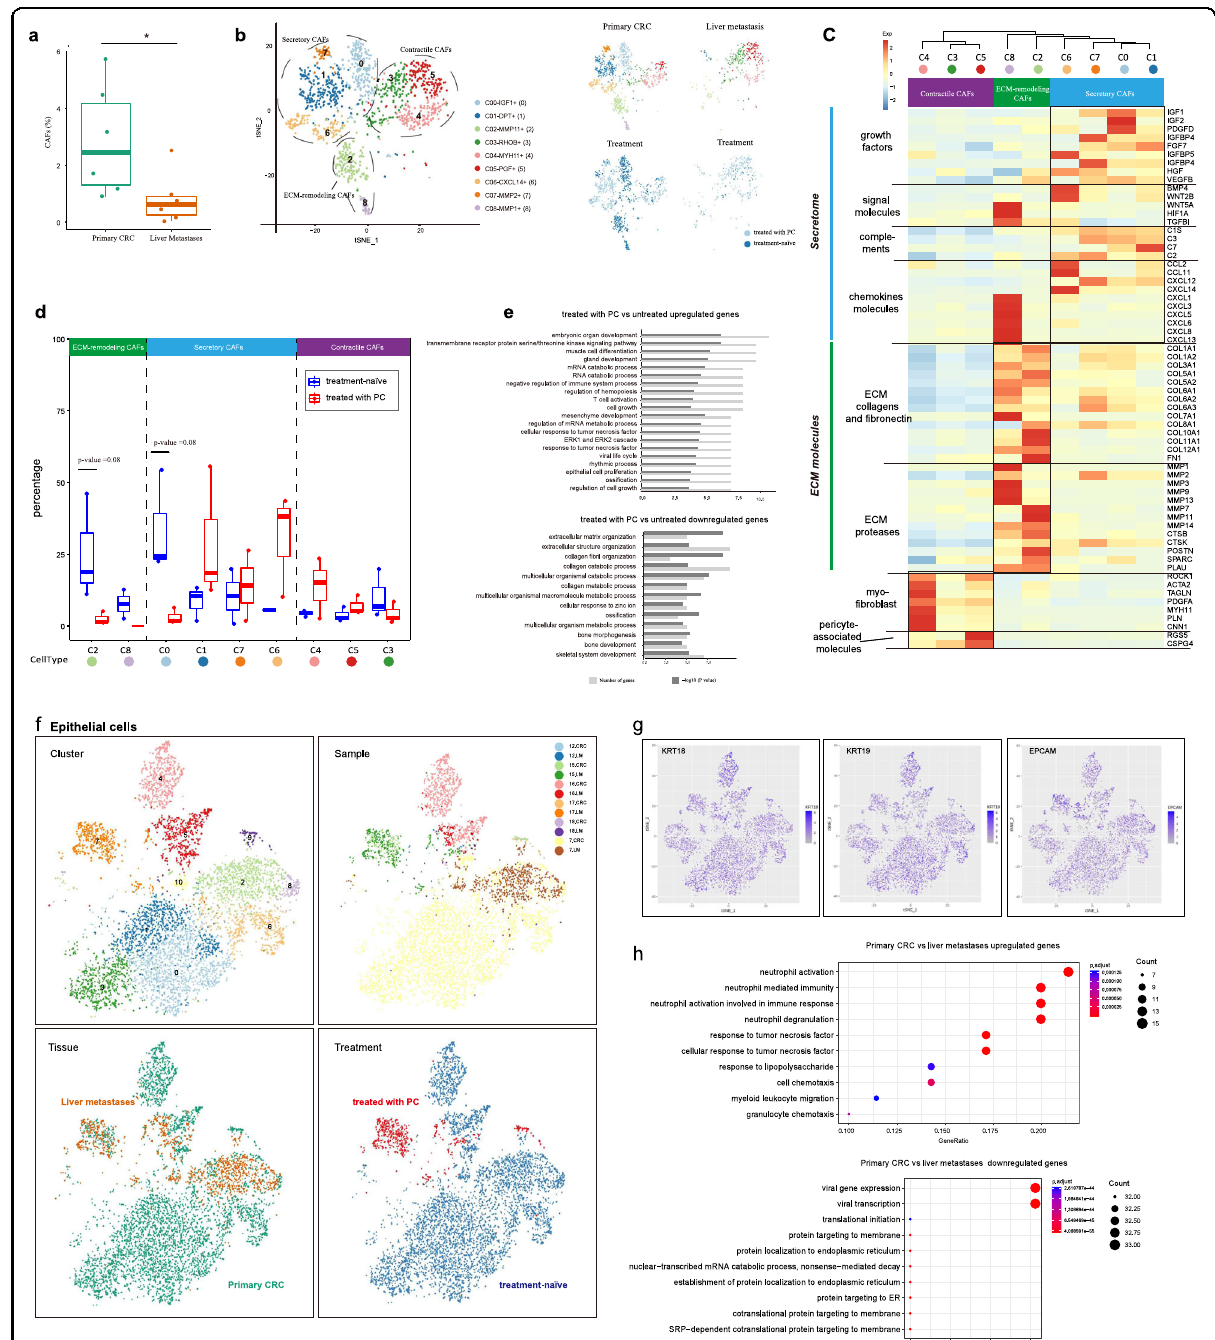
Fig. 4 Compositions and phenotypes of CAFs and EPCs in primary CRC and liver metastases. a The percentage of CAFs in six primary CRC and six matched liver metastasis samples from six CRC patients with liver metastatic disease. Each dot represents one sample. * P = 0.031, two-sided Wilcoxon rank-sum test. b t-SNE plot showing a total of 1383 fi broblasts that can be separated into nine subtypes. Cells are colored according to different cell types (left), tissue origins (right, top), and treatment status (right, bottom). c Heat map showing the selected marker genes in each cluster. Relative expression was de fi ned as the gene-wise (row) z-score of normalized UMI counts across CAF subtypes (column). d Box plots showing the percentage of each CAF subtype in primary CRC tumors treated with or without PC. Wilcoxon rank-sum test was used for statistical analysis. e GO analyses of genes that are differentially expressed between CAFs from tumors treated with PC and those from treatment-naïve tumors. Benjamini- Hochberg-corrected P values < 0.01. f Reclustering of EPCAM + cells, colored according to clusters, sample origins, tissue origins, and treatment status. g t-SNE plots showing representative marker genes of EPCs. h GO analysis of genes that are differentially expressed between primary CRC and liver metastases in malignant cells. Selected GO terms with Benjamini-Hochberg-corrected P values < 0.05 (one-sided Fisher ’ s exact